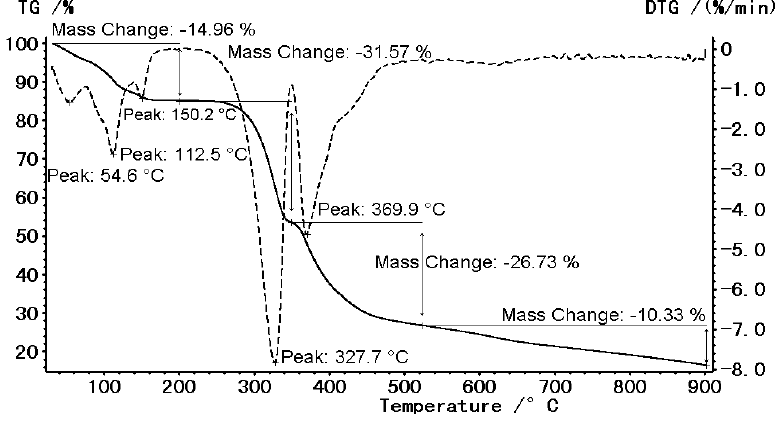
Figure 4. TG and DTG analysis for compound ( 1 ).